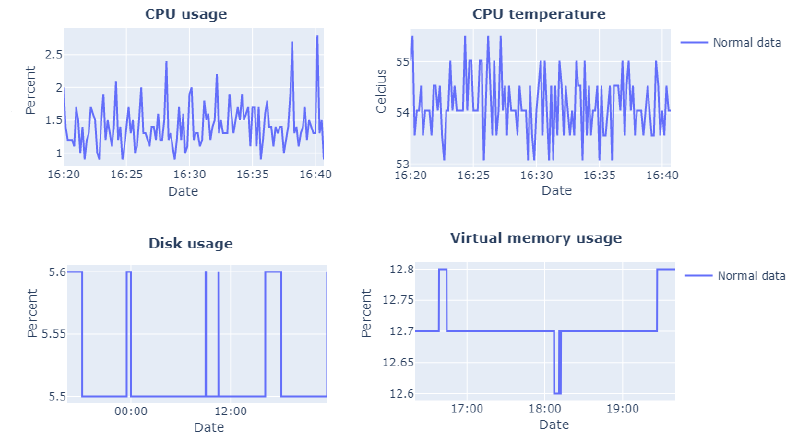
Figure 15. Examples of normal edge monitored data.